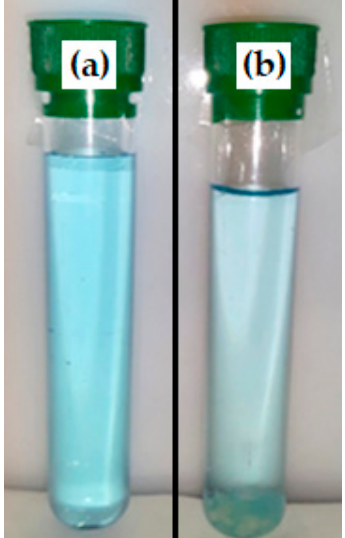
Figure 11. Blue ink removal with CNF-g-CH.